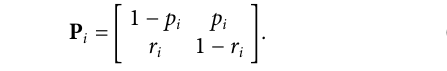
Frontiers in Communications and Networks |